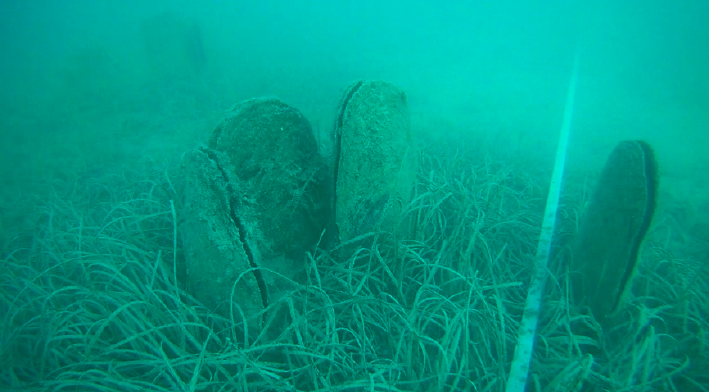
Figure 4. Clinical inspection of the live noble pen shells in situ, where both healthy and sick animals were in an upward position. Differentiation between them was made by checking their reactions to stimuli. The healthy specimens quickly closed their shells.